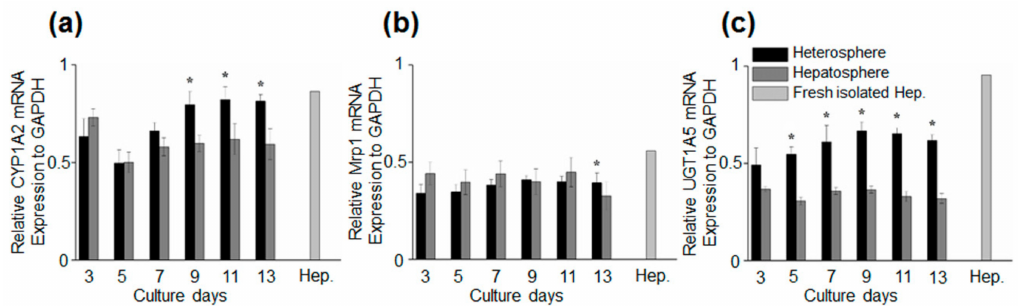
Figure 5. Time-course of marker expression for specific hepatocytes. The quantification of the relative gene expression of ( a ) CYP1A2, ( b ) Mrp1, and ( c ) UGT1A5. Data are represented as the mean ± standard error (SE) of three independent experiments. * p <